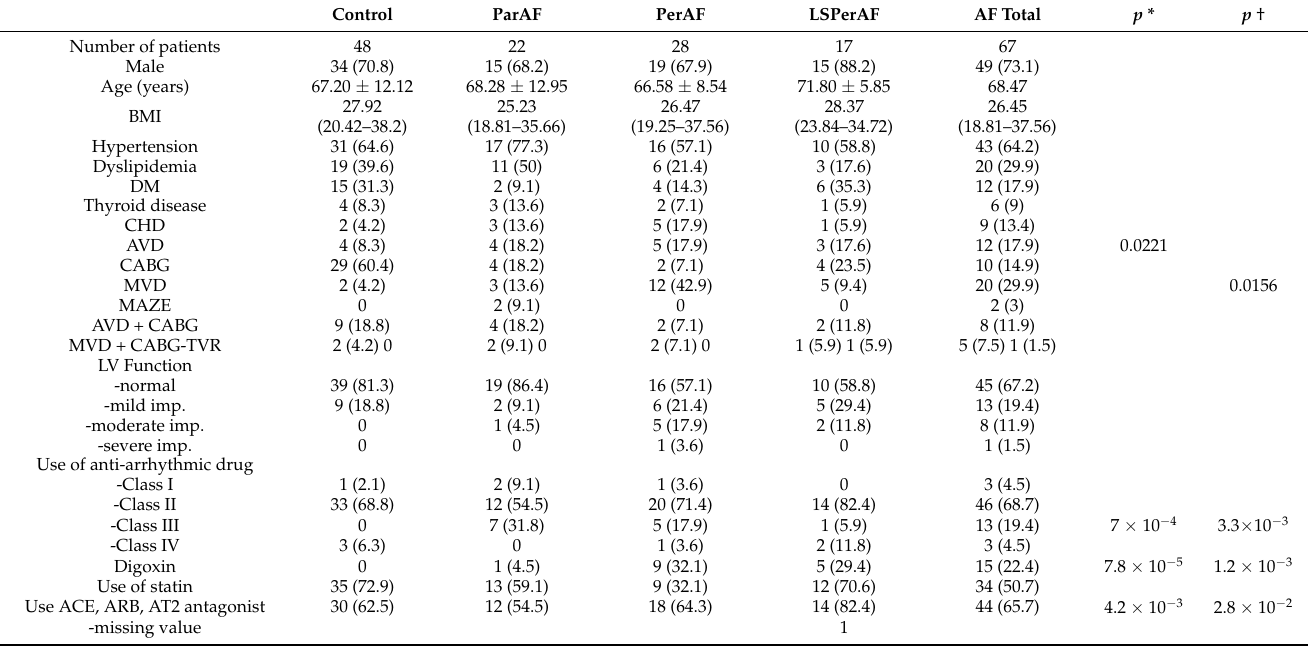
Table 1. Patients